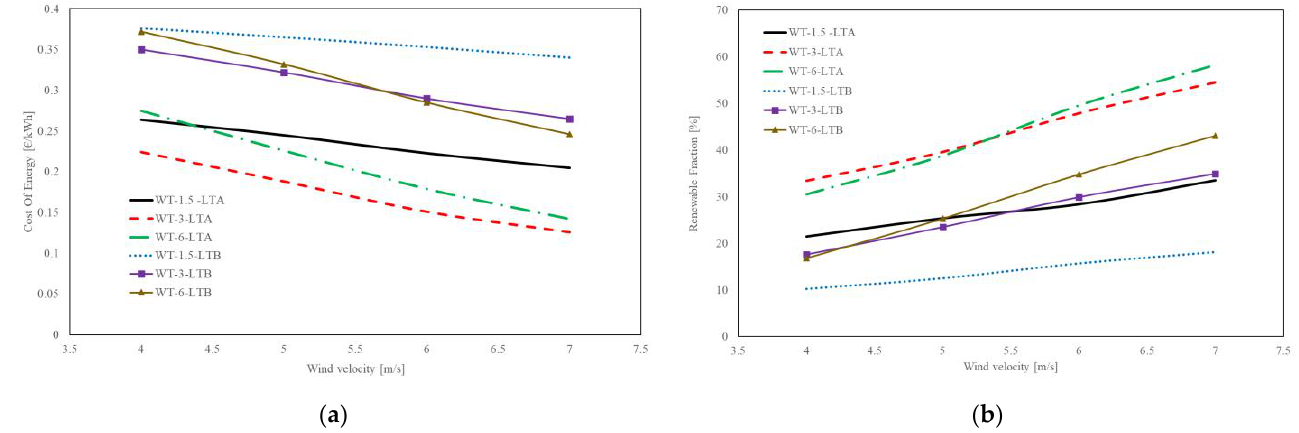
Figure 8. Wind potential parametric study for the 2nd examined wind pattern for different wind turbines. ( a ) COE vs. wind velocity; ( b ) Ren.Fr. vs. wind velocity.